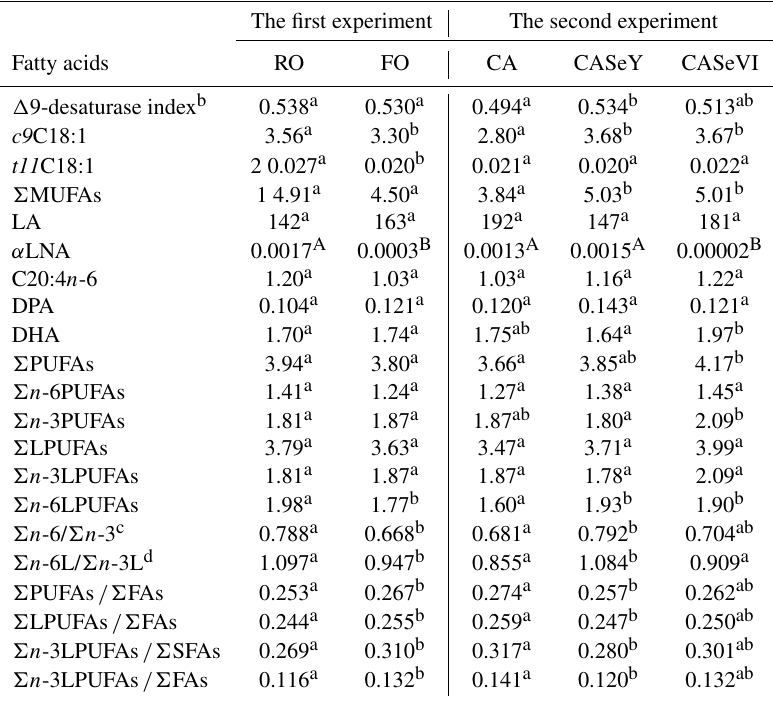
Table 4. The concentrations (mgg − 1 ) of fatty acids, values of (cid:49) 9-desaturase index and ratios of P PUFAs, P LPUFAs and P n -3LPUFAs to P SFAs or P FAs in the brains of lambs a . The first experiment The second experiment Fatty acids RO FO CA CASeY CASeVI (cid:49) 9-desaturase index b 0.538